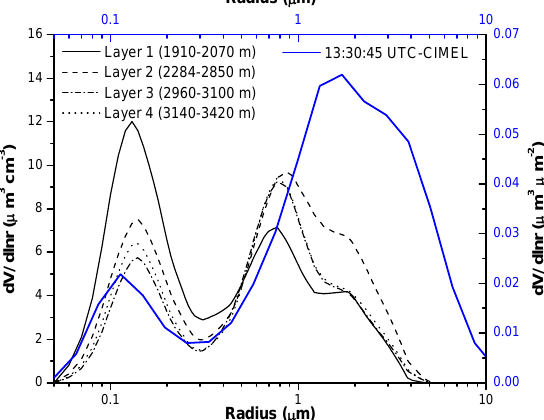
Fig. 7. Retrieved aerosol volume size distribution from the NTUA Raman lidar data for radiuses up to 10µm, for the particles in layers 1 (1910–2070m), 2 (2284–2850m), 3 (2960–3100m) and 4 (3140– 3420m) between 17:40–20:40UTC (left vertical axis). Measured aerosol volume size distribution (total column) by the CIMEL sun- sky radiometer on 2 April 2009, at 13:30UTC. (right vertical axis).